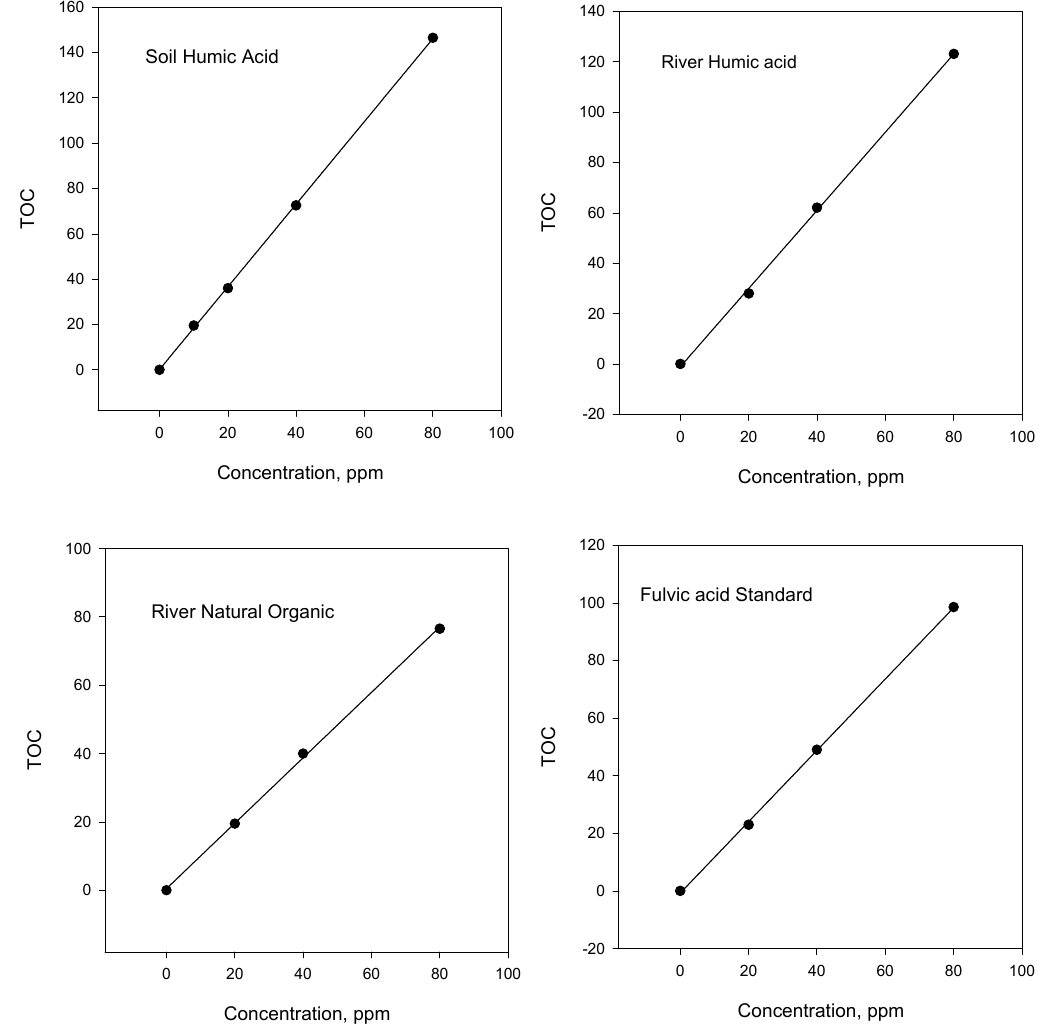
Figure 2. Total organic carbon (TOC) of selected